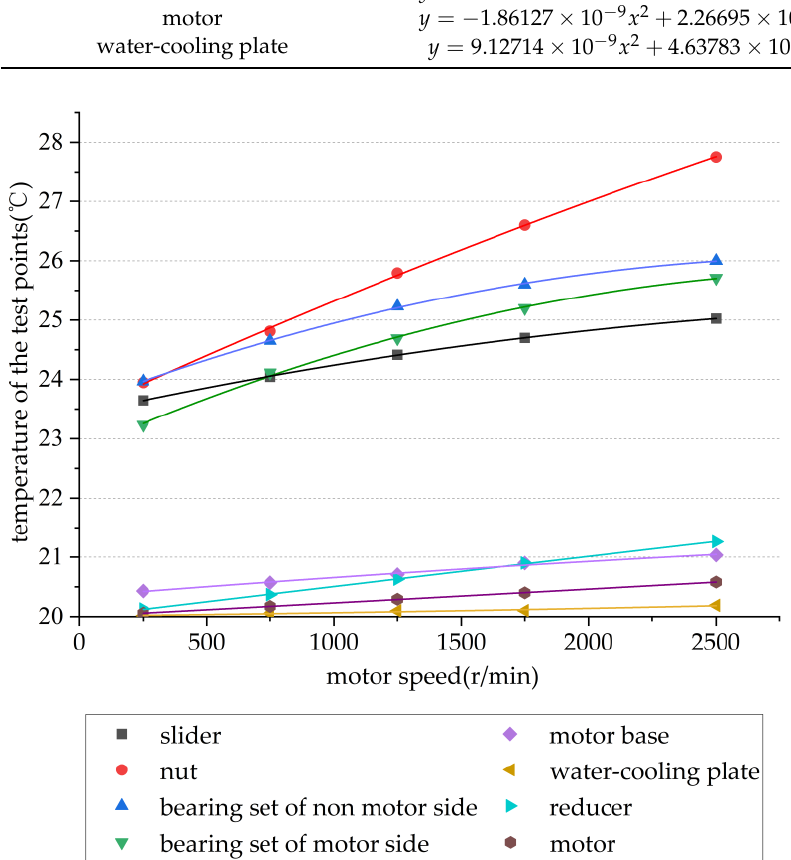
Figure 20. The effect of different rotational speeds on the temperature of test points.